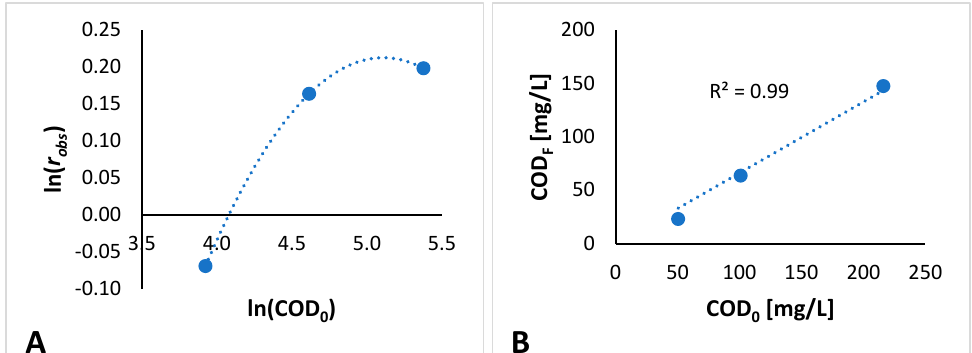
Figure 6. The effect of ρ B on ( A ) the observed reaction rate constant, k obs , and ( B ) the COD removal.